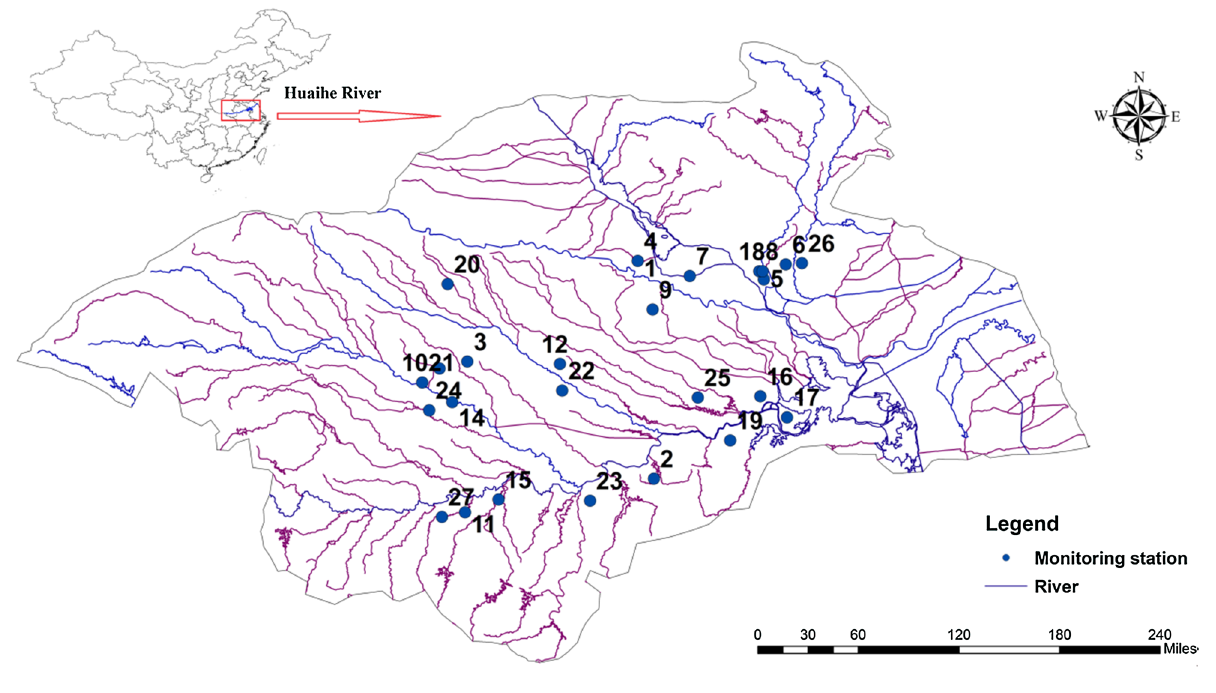
Fig. 1 Spatial distributions of water quality monitoring stations of Huaihe River